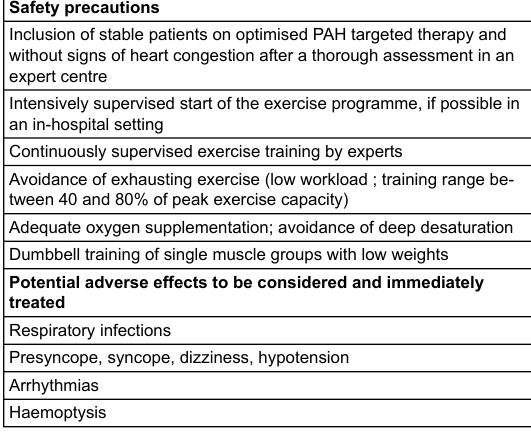
Table 2: Safety precautions and adverse effects of exercise training in pulmonary arterial hypertension (PAH). Safety